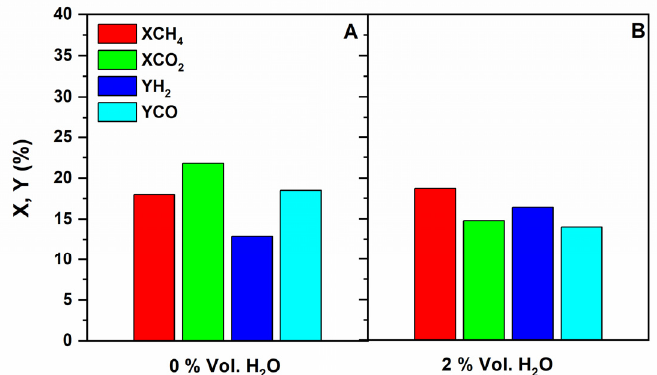
Figure 11. Conversions and yields for the DRM reaction carried out in the CR over the Ru/ZrO 2 - La 2 O 3 catalyst with ( A ) and without H 2 O ( B ) in the feed; Feed composition: CH 4 : CO 2 : He = 10:10:80 ( A ) and CH 4 :CO 2 :H 2 O:He = 10:10:2:78 ( B ); Total flow rate = 100 mL/min; T = 500 °C; P = 1 bar.